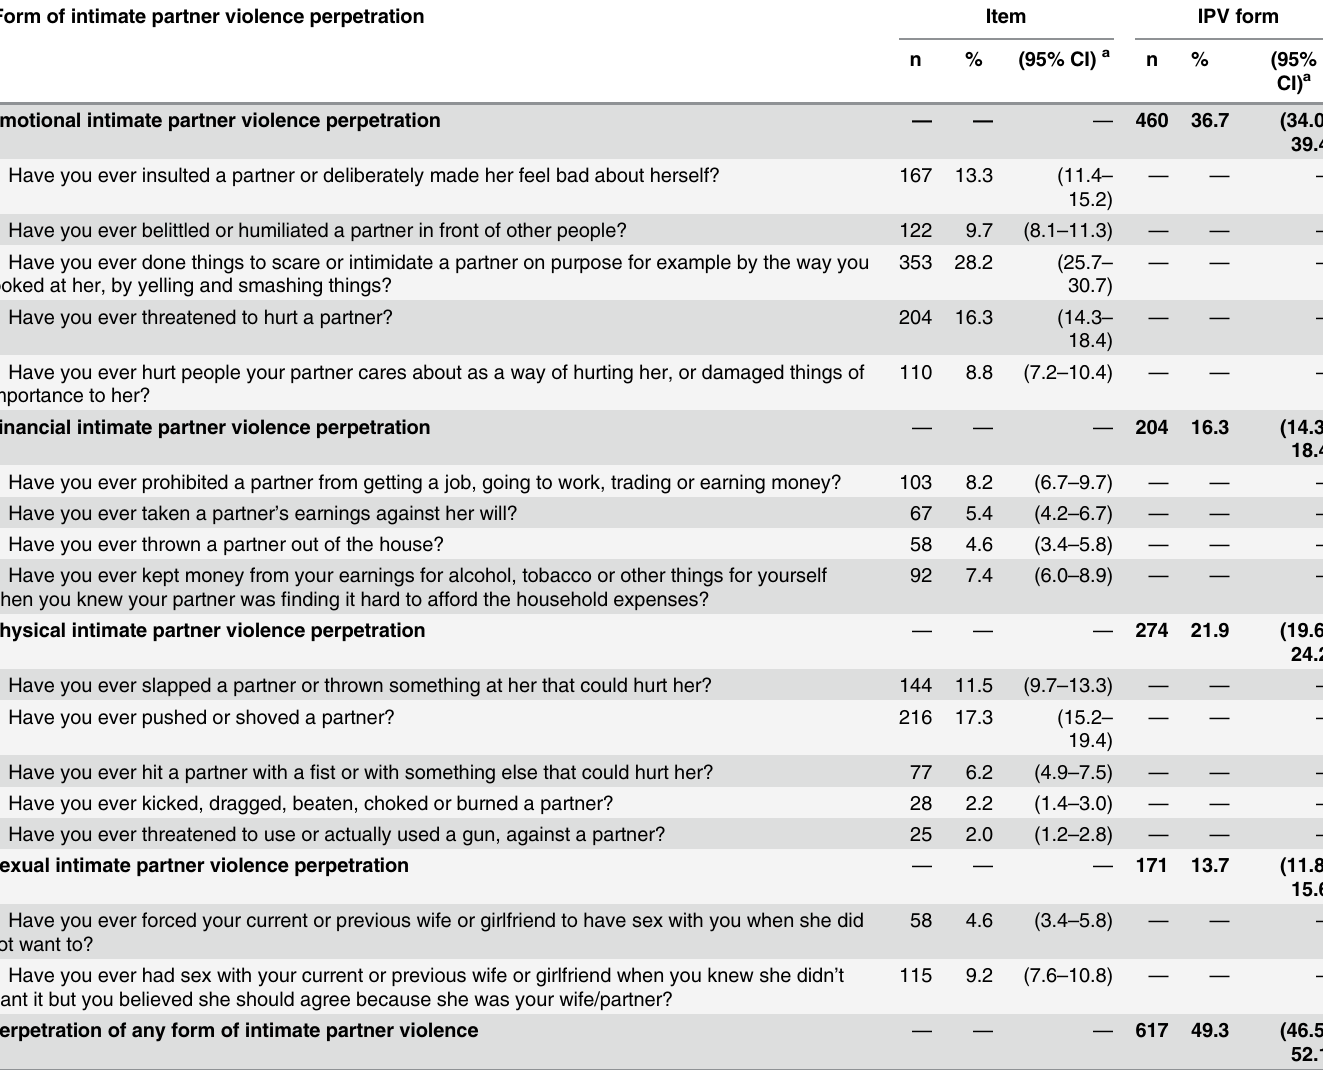
Table 3. Intimate partner violence (IPV) perpetration forms and item prevalence among ever-partnered Sri Lankan men (n = 1252), UN Multi-Coun- try Study on Men and Violence in Asia and the Pacific, Sri Lanka, 2011 –